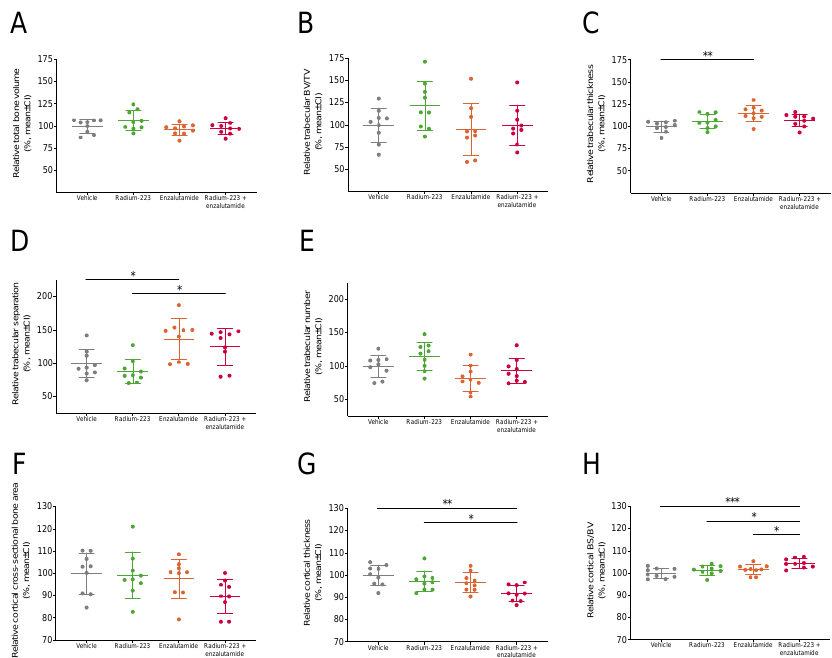
Figure 6. Radium-223 and enzalutamide combination treatment does not affect bone microarchi- tecture. The mice ( n = 9/group) were treated with vehicle, radium-223 (330 kBq/kg, Q4W × 2, i.v.), enzalutamide (30 mg/kg, QD, p.o.), or their combination. Bone structure parameters